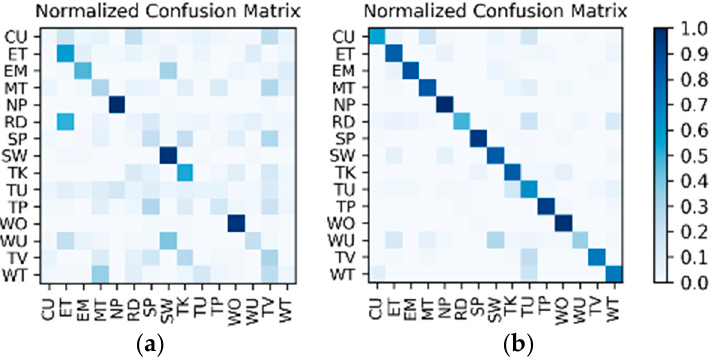
Figure 16. W1’s confusion matrix using a single sensor: ( a ) IMU; ( b ) photo stream.